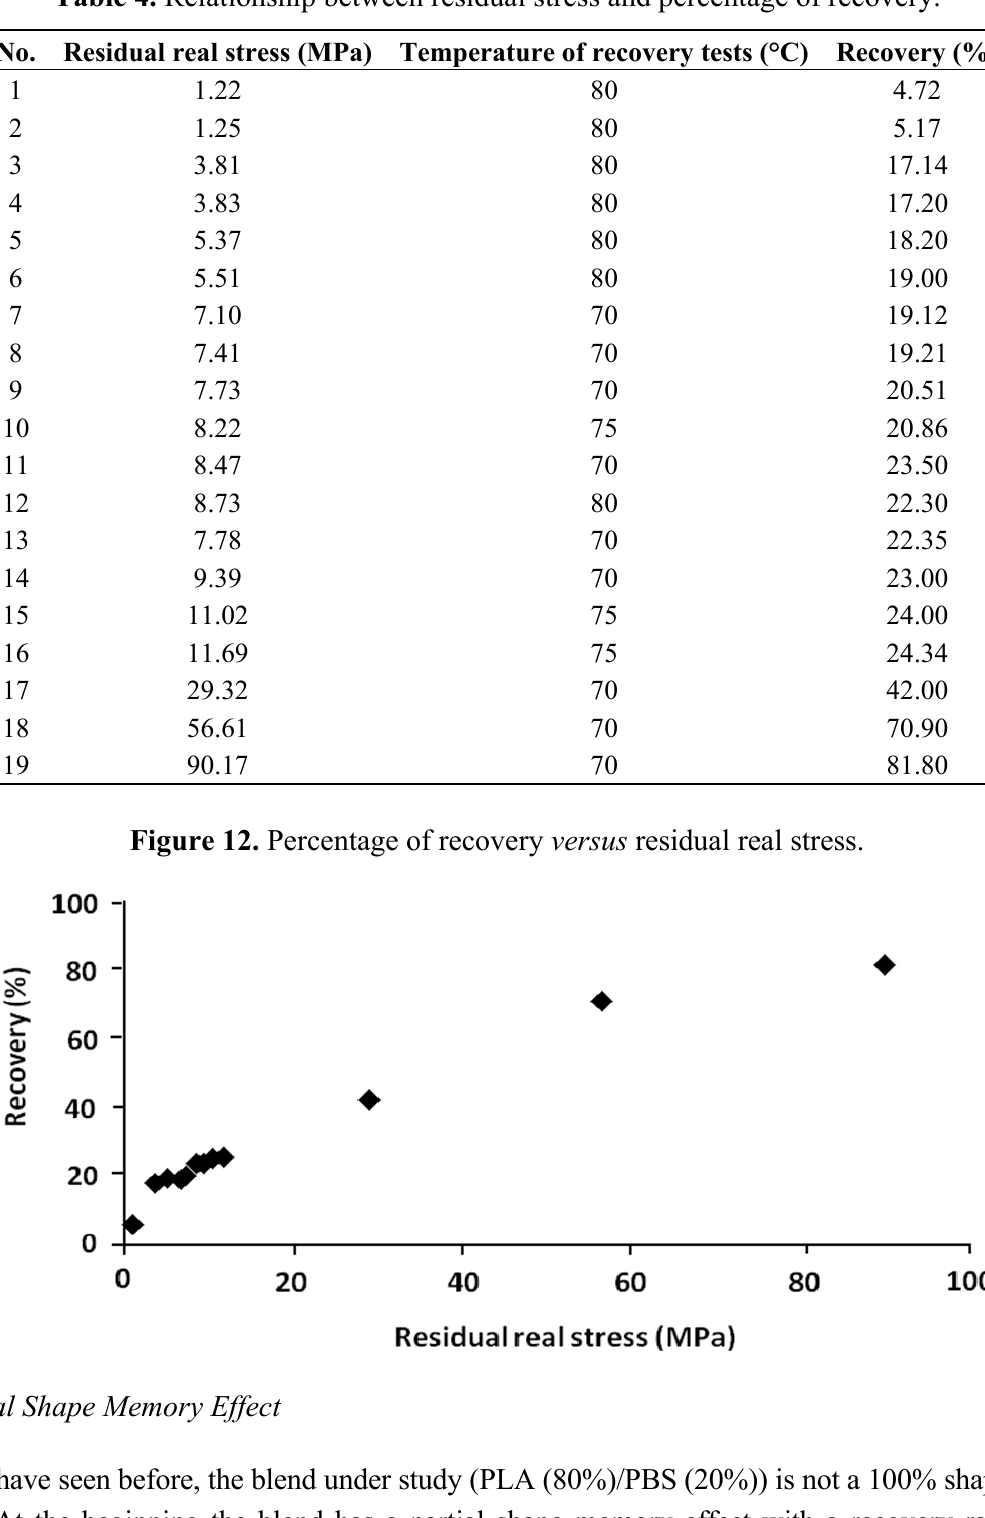
Table 4. Relationship between residual stress and percentage of recovery.